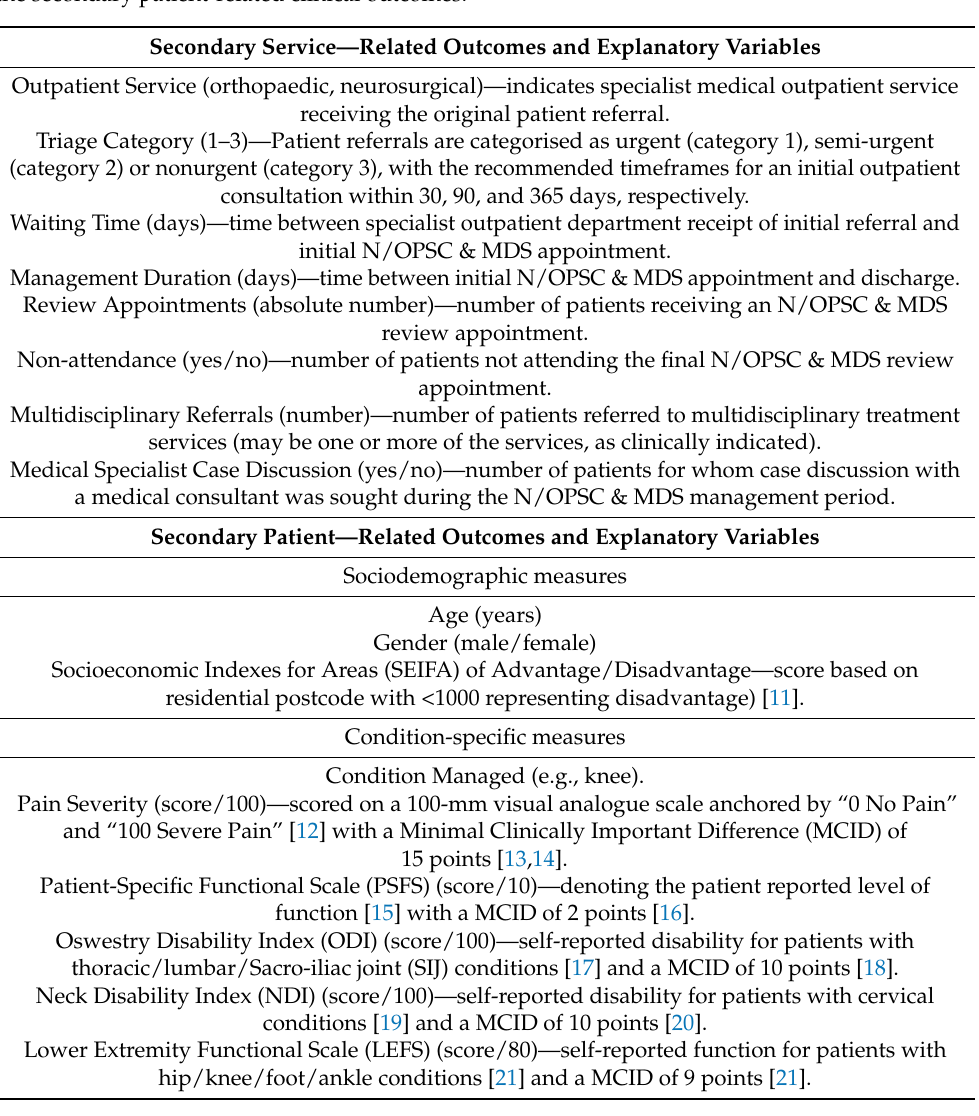
Table 1. Secondary outcomes and potential explanatory variables (units/categories) included in the analysis. The condition specific, general health, and psychological measures were recorded at the initial consultation and discharge, with changes in these measures with respect to time representing the secondary patient-related clinical